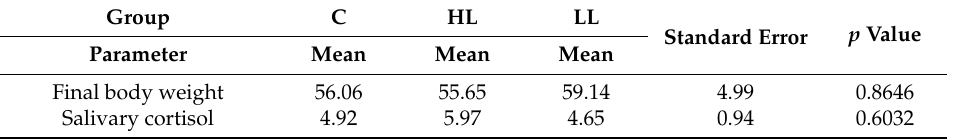
Table 9. Final body weight (kg) and salivary cortisol concentration (ng/mL) of the three groups. Group C